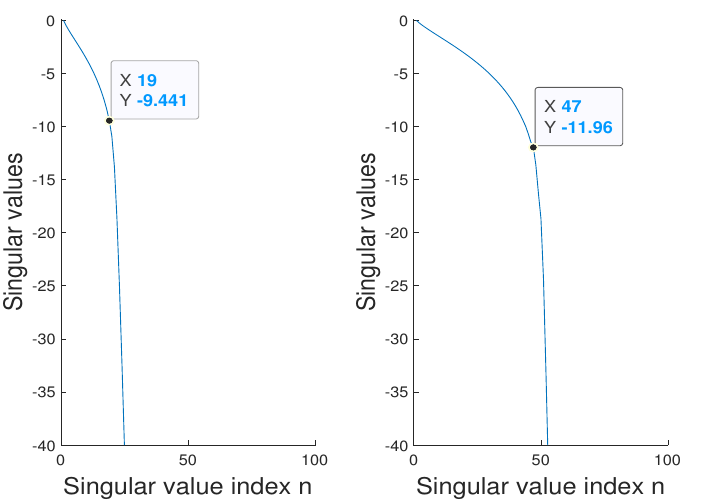
Figure 2. Normalized singular value behavior of the operator A in db for z 1 = 2 λ and z 2 = 50 λ . On the left, a = 30 λ , on the right a = 15 × 10 3 λ